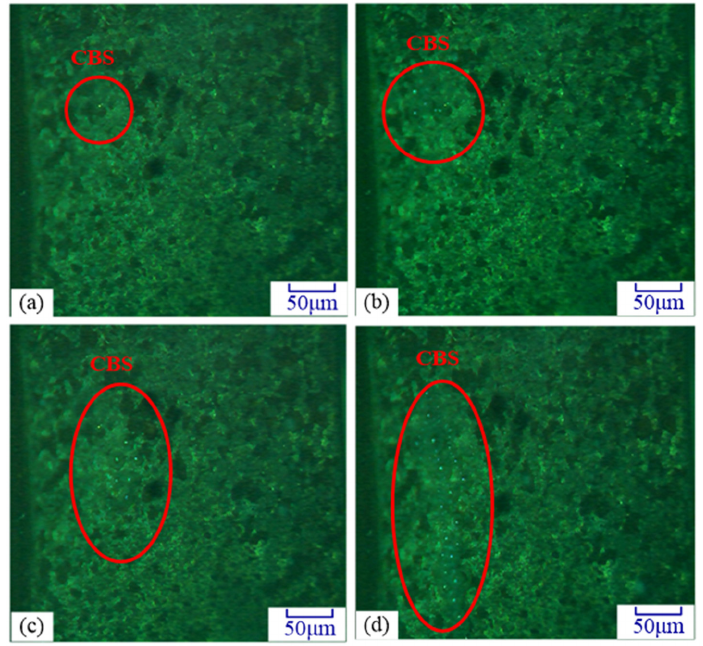
Figure 8. Effect of ultrasonic amplitude on the cavitation. ( a ) A = 6.4 µ m; ( b ) A = 8.3 µ m; ( c ) A = 10.2 µ m; ( d ) A = 12.5 µ m.